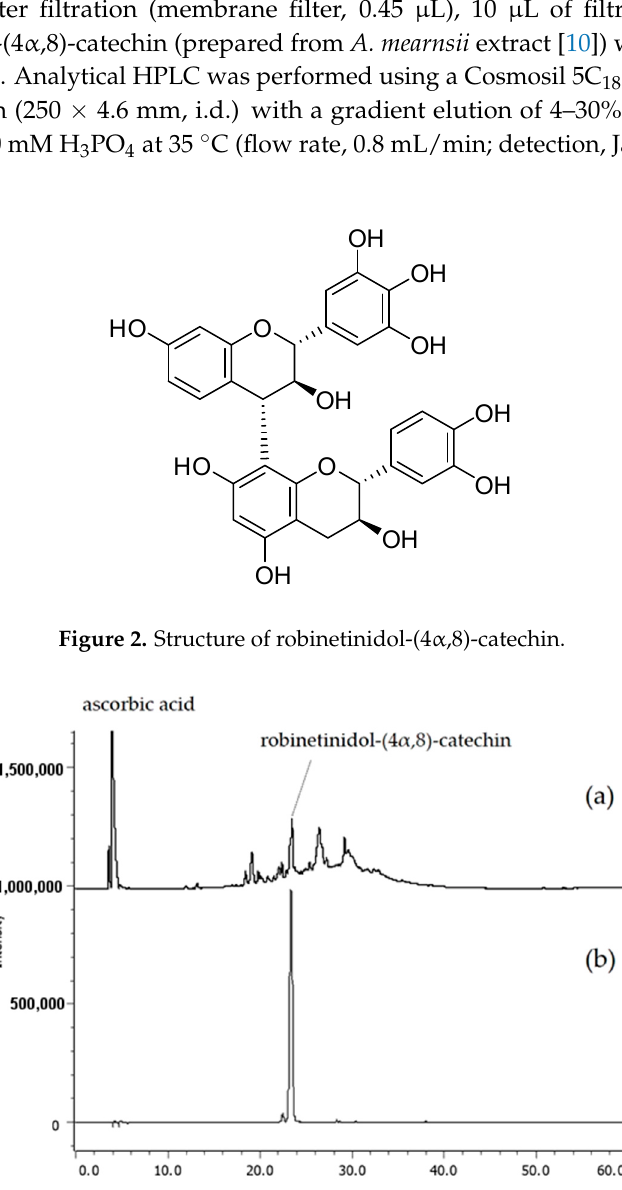
Figure 3. HPLC profiles of ( a ) ACAPOLIA PLUS (1 tablet/10 mL) and ( b ) robinetinidol-(4 α ,8)-catechin. Detection wavelength: 230 nm; injected volume: 10 μ L for each sample.